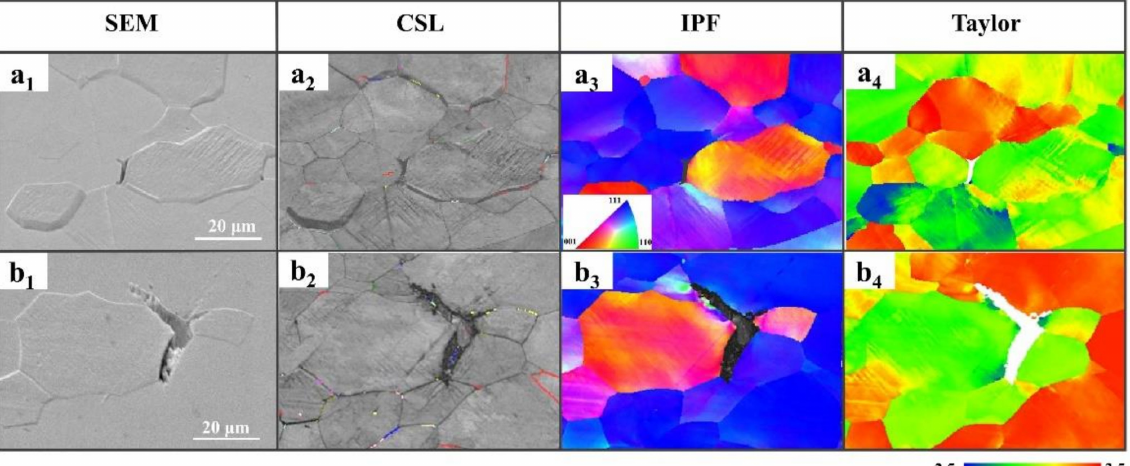
Figure 8. Two different fields of hydrogen-charged specimen: SEM microstructure ( a 1 , b 1 ) and EBSD map ( a 2 – a 4 , b 2 – b 4 ) analysis of the cracks on the surface of RD-TD; ( a 2 , b 2 ) CSL maps, where the red line is Σ 3 GB; ( a 3 , b 3 ) IPF maps; ( a 4 , b 4 ) Taylor